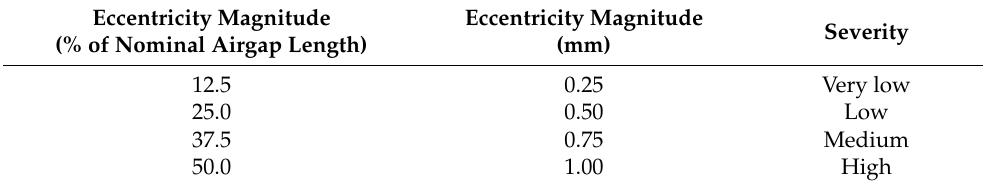
Table 3. Eccentricity magnitudes analyzed in the selected PMSMs.